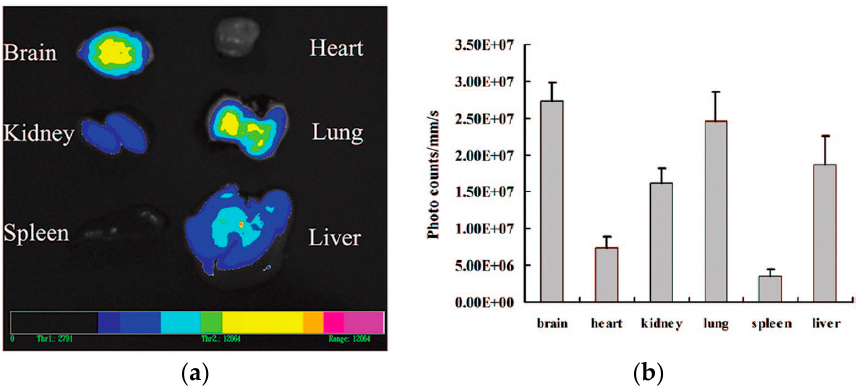
Figure 6. Distribution of wheat germ agglutinin (WGA)-conjugated quantum dots-loaded nanoparticles in various organs, 3 h after intranasal administration: ( a ) optical image ( b ) quantification of luminescence signals (adapted with permission from [153]. Copyright 2008 American Chemical Society).